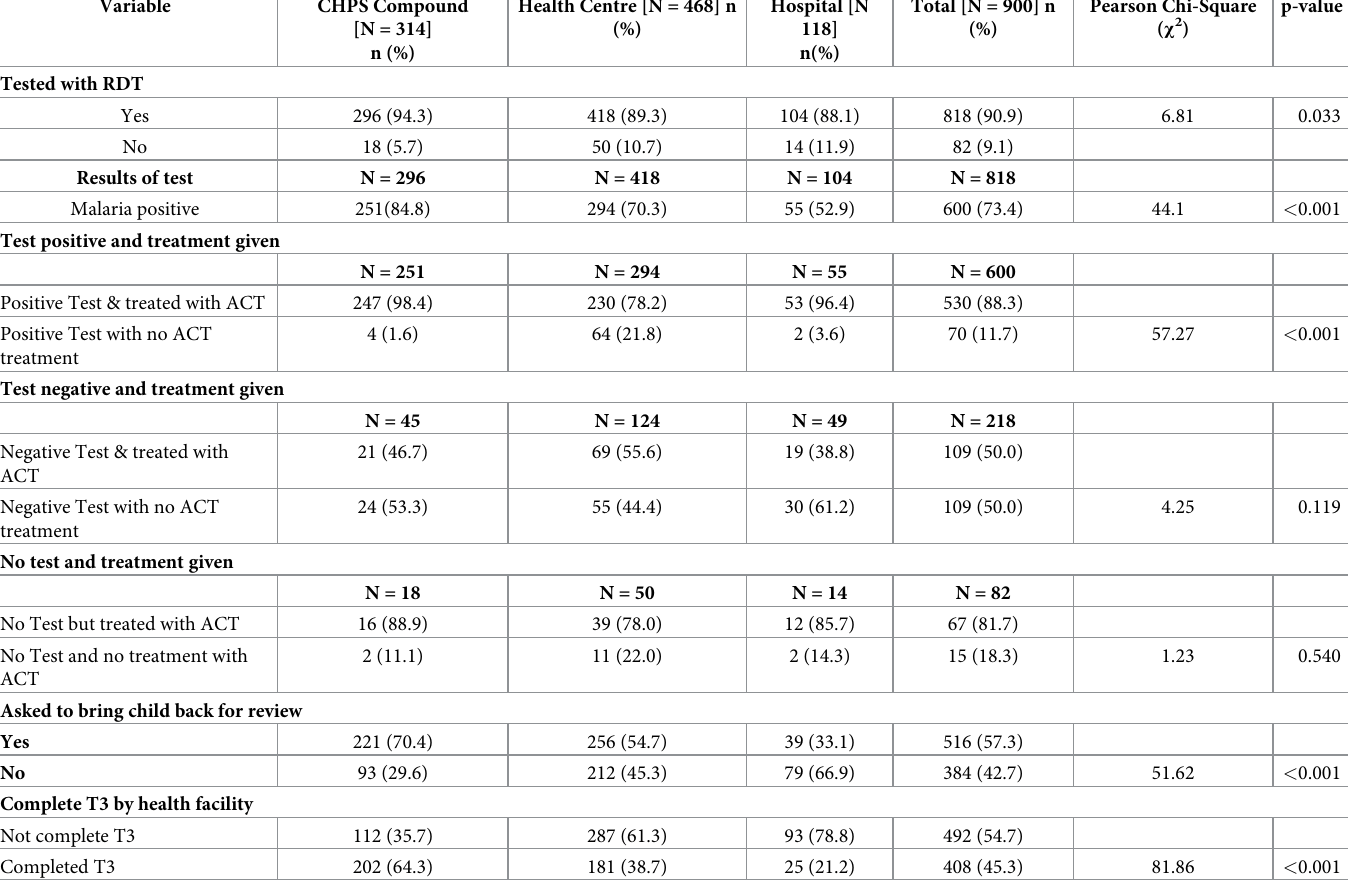
Table 2. Distribution of blood test carried out, test results and treatment given by level of health facility.